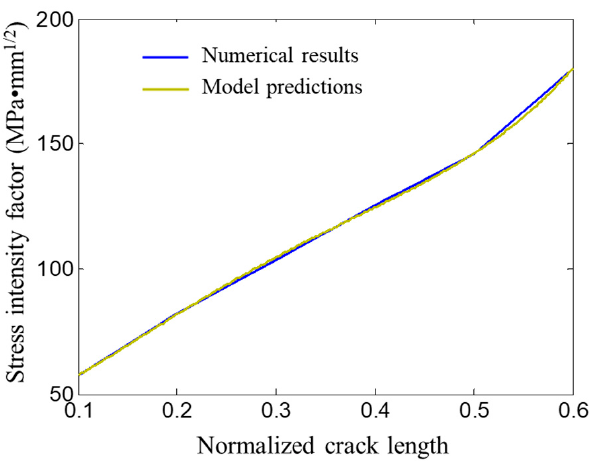
Figure 13. Comparison between numerical results and model predictions under load of 200 MPa.